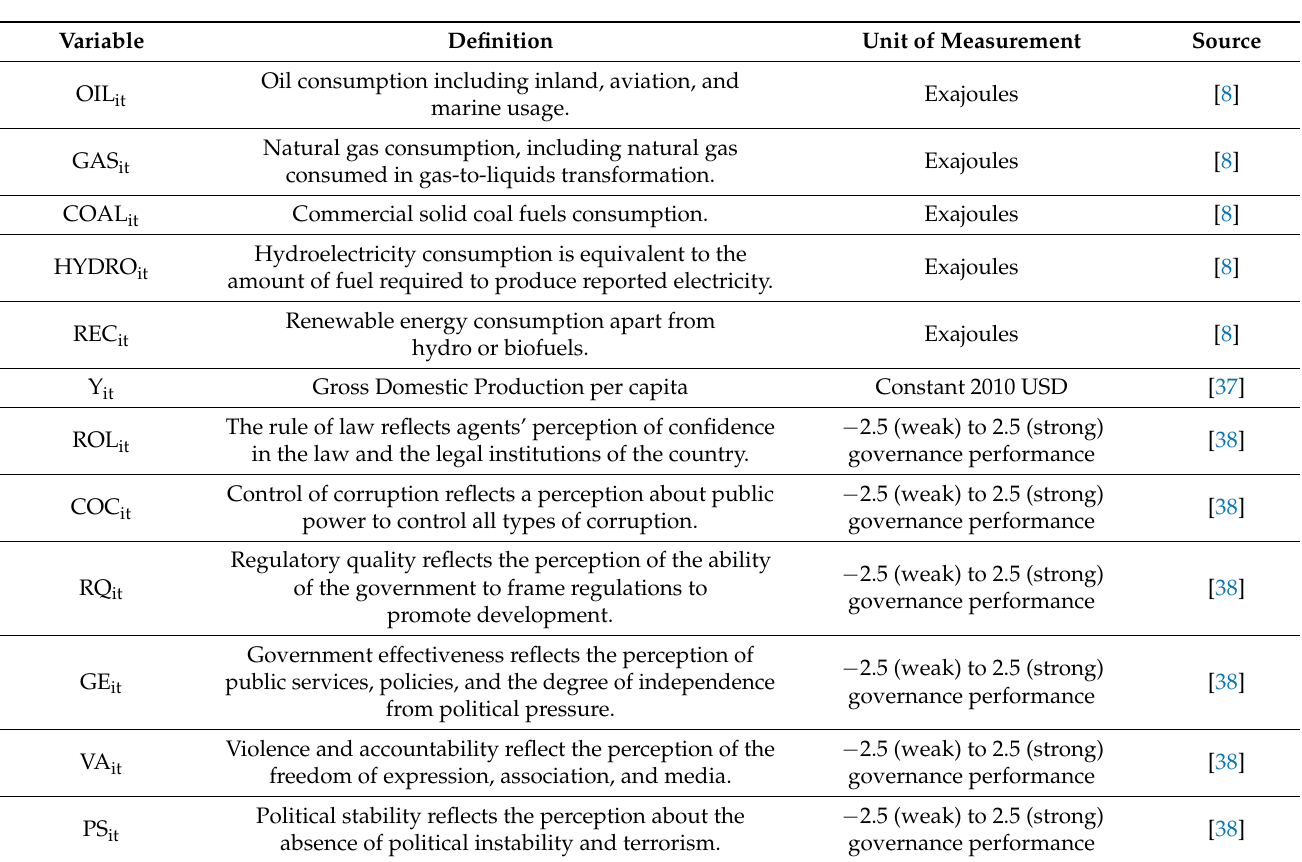
Table 2. Definition of